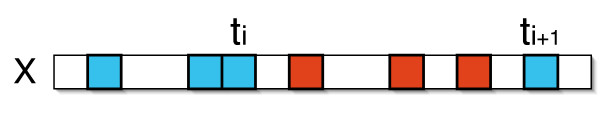
Inside. The red subsequence is inside the blue subsequence T . All the characters of the red subsequence occur between the indices ti and ti+1 of T.